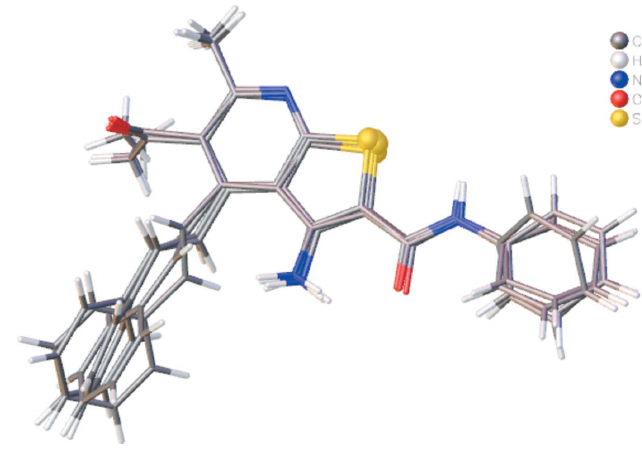
Figure 2 Molecule I with displacement ellipsoids for the non-hydrogen atoms drawn at the 30% probability level. The intramolecular N—H (cid:2)(cid:2)(cid:2) O hydrogen bond is depicted by a dashed line.